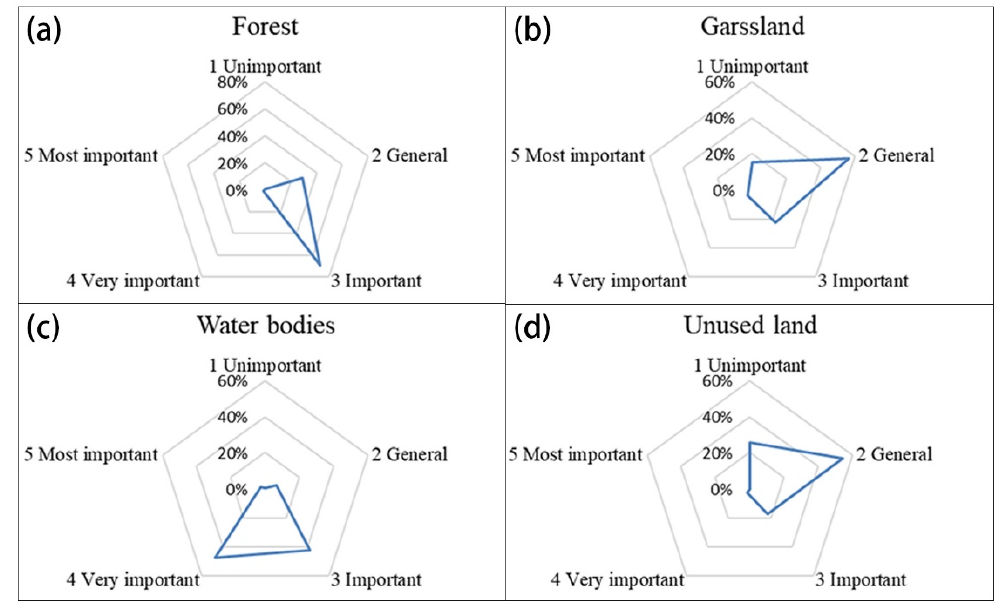
Figure 5. Distribution of ecological land by classification ( unimportant to most important ) and land type: ( a ) forest; ( b ) grass- land; ( c ) water body; ( d ) unused land.